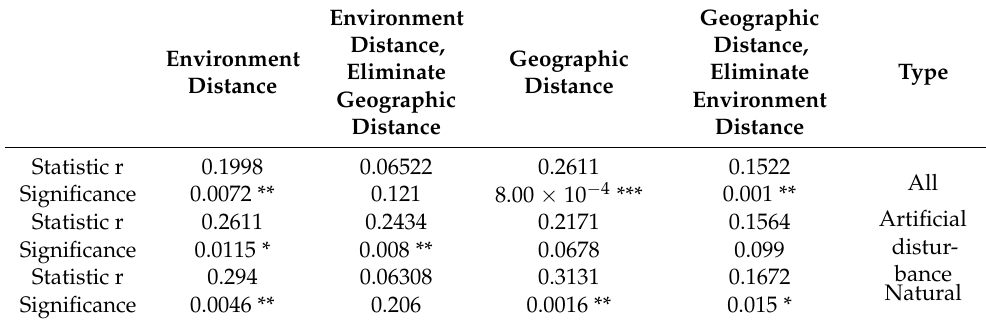
Figure 7. Variation in the diversity index along the latitude ( A ) and altitude ( B ) gradients. Table 4. Mantel and partial Mantel test between β -diversity and environment/geographic